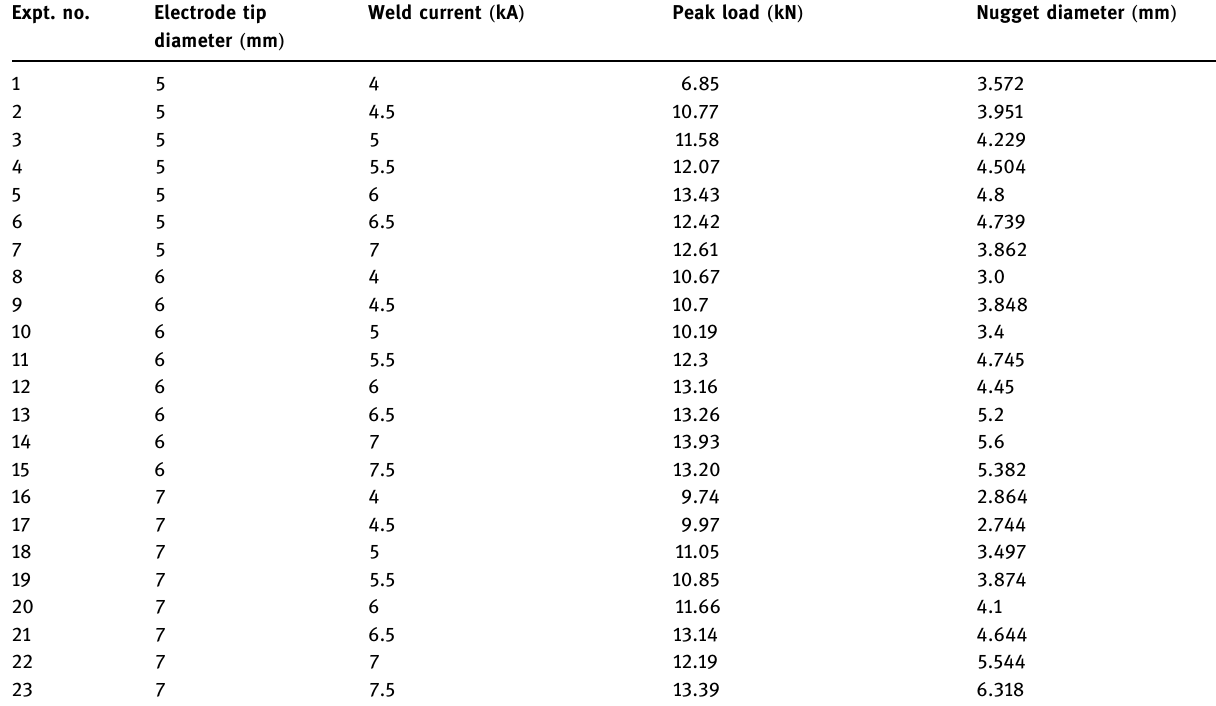
Table 2: Parameter setting and measured responses for various experiments Expt. no. Electrode tip